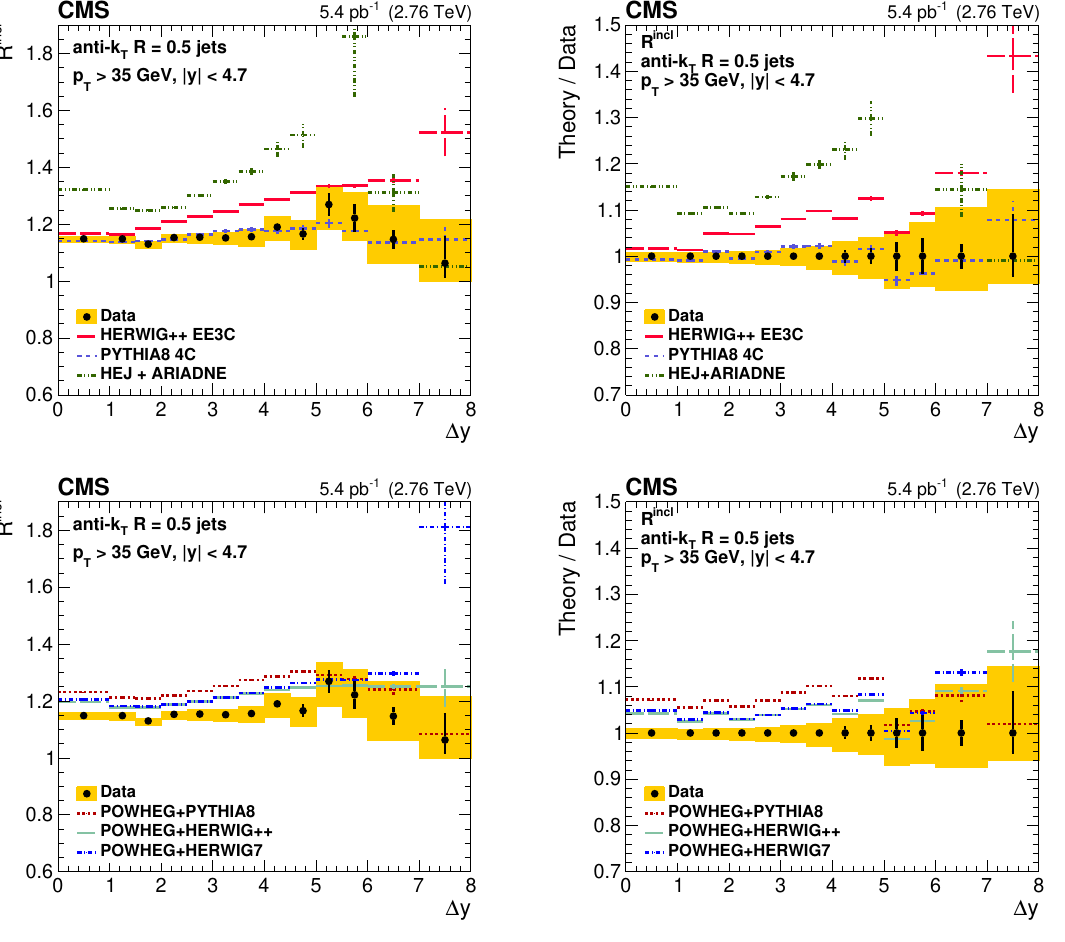
Figure 4 . Ratio R incl of the cross sections for inclusive to “exclusive” dijet production. The upper and lower rows present the comparison with different MC models. The plots on the left present the ratio R incl and those on the right the ratio of theory to data. The systematic uncertainties are indicated by the shaded bands and the statistical uncertainties by the vertical